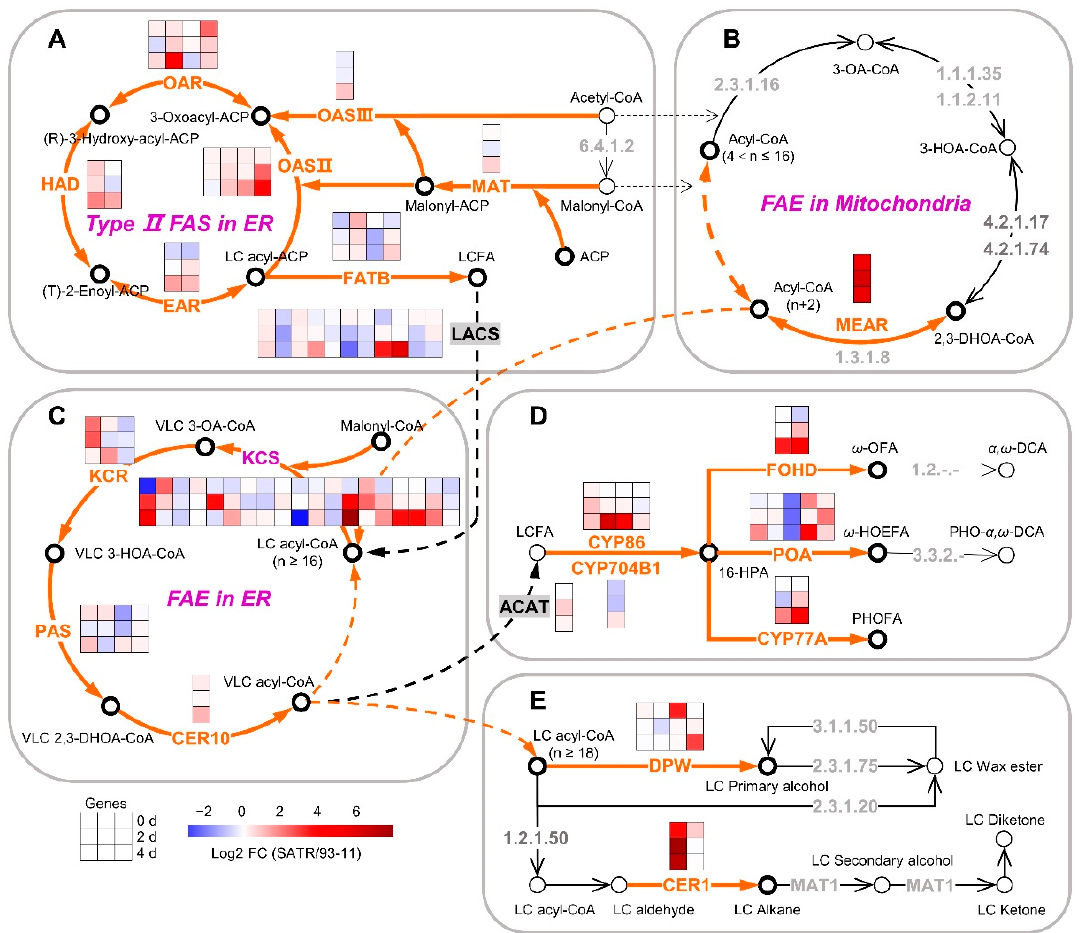
Figure 3. Gene expression analysis in cutin, suberin and wax biosynthesis pathway between SATR and 93-11 under SSAS. ( A – E ) Gene expression analysis of the cutin, suberin and wax biosynthesis pathway mainly including Type II fatty acid biosynthesis (FAS) in endoplasmic reticulum (ER) ( A ), fatty acid elongation (FAE) in mitochondria ( B ), FAE in ER ( C ), cutin and suberin ( D ) and wax biosynthesis ( E ) between SATR and 93-11 under SSAS for 0 days, 2 days and 4 days. The meanings of arrows, open circles and the black symbols beside them, orange name, and color of small inner cell in the big composite box are the same as that indicated in Figure 2. The detailed information of these enzyme-encoding genes and full names of the metabolites were summarized in Table S4, respectively. The thresholds for DEGs are |log2 [fold change (SATR/93-11)]| > 0.5850 (1.5-fold change value of gene expressions in SATR compared with 93-11) and p -value < 0.05.